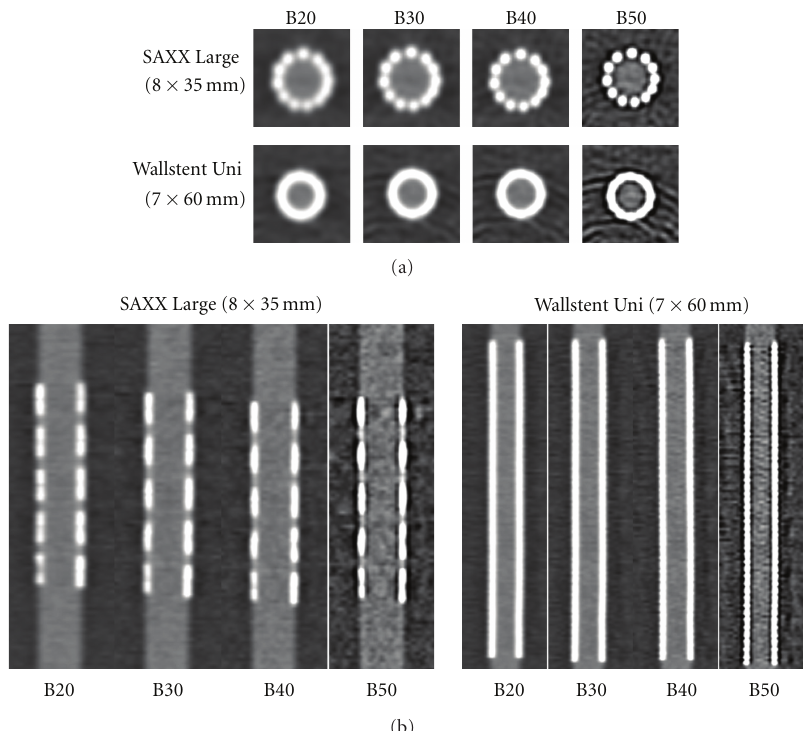
Figure 1: Comparison of the four di ff erent reconstruction protocols. Exemplary axial (a) and through-plane (b) reformations of the SAXX Large and the Wallstent Uni in the four applied reconstruction protocols B20f, B30f, B40f, and B50f. Note the increase of the visible lumen diameter and the increase of noise using the B50f reconstruction kernel.